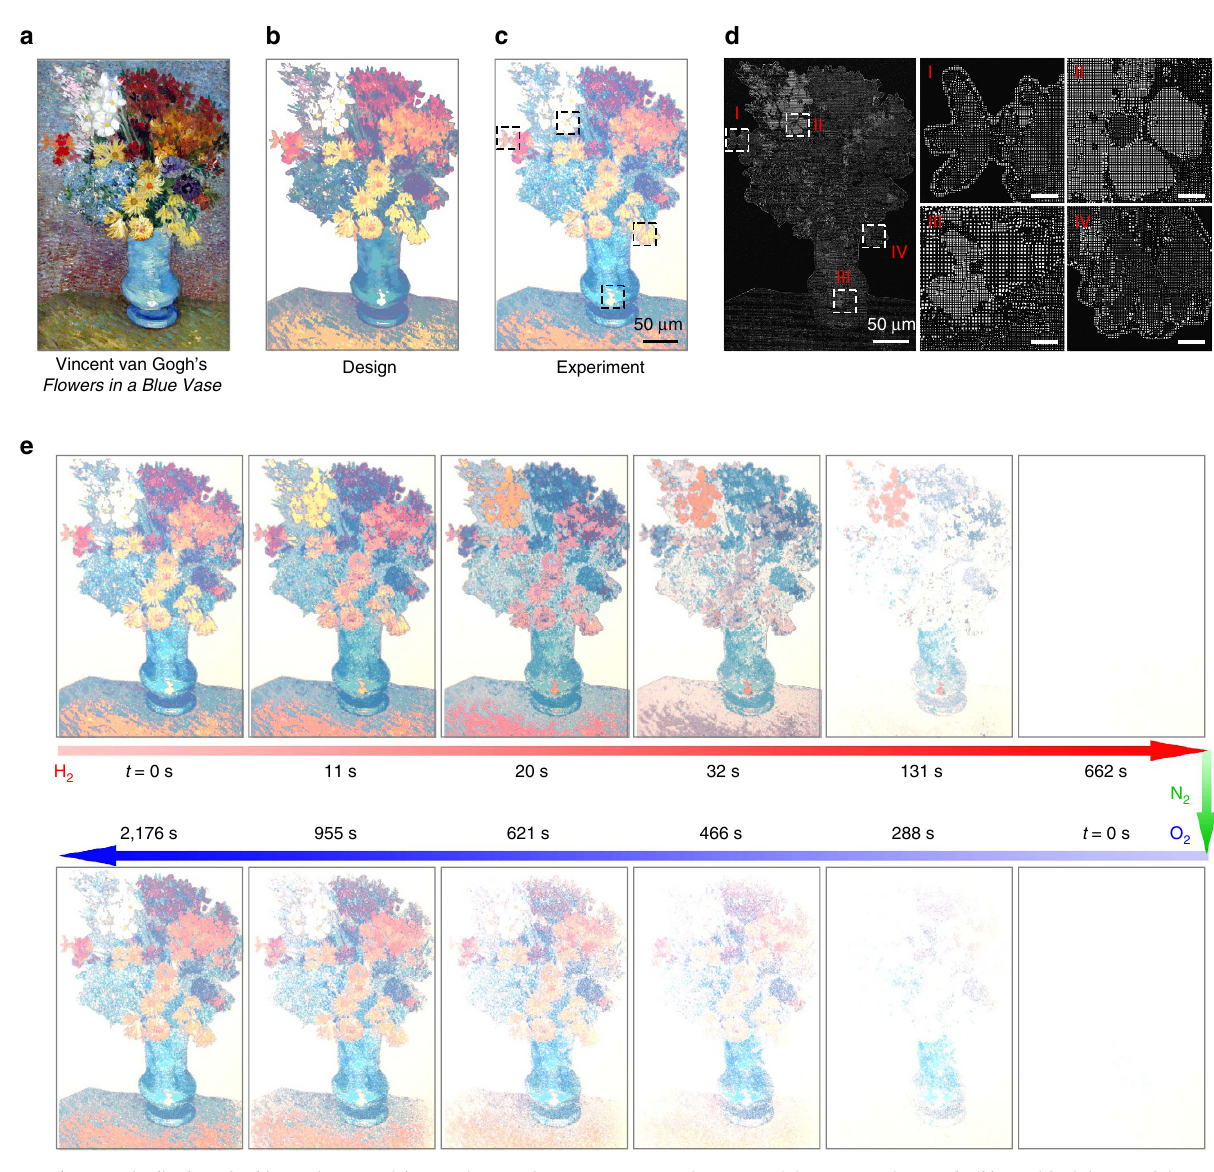
Figure 5 | Dynamic display of arbitrary images. ( a ) Digital copy of a Vincent van Gogh painting ( Flowers in a Blue Vase ). ( b ) Modified design of the original artwork in order to highlight the dynamic changes of the flowers. ( c ) Optical micrograph of the modified artwork. ( d ) Overview and enlarged SEM images of the microprint. Scale bars are 5 m m in the enlarged images. ( e ) Dynamic processes of the plasmonic artwork display during hydrogenation and dehydrogenation for colour erasing and restoring,